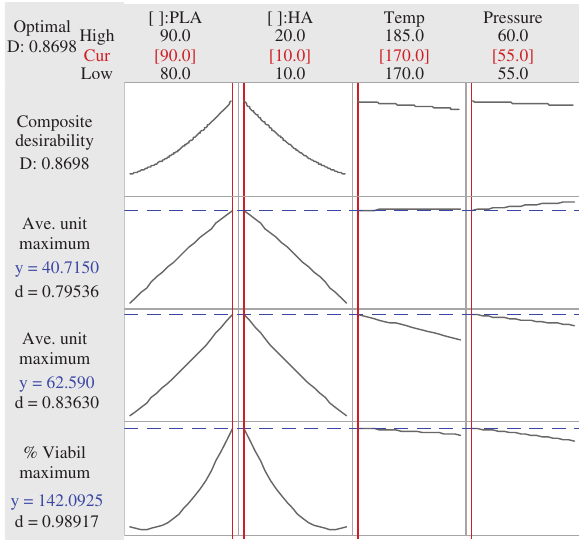
Figure 8: Factor